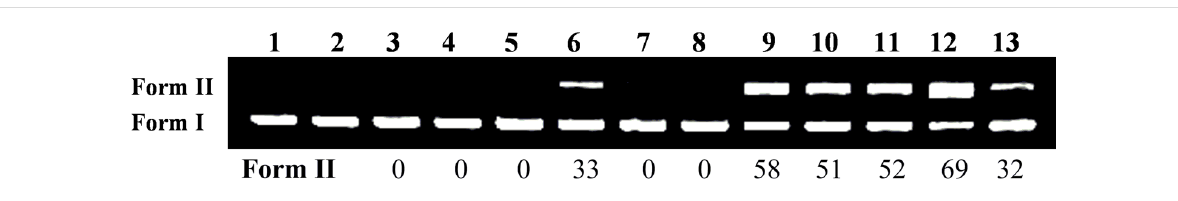
Figure 8: DNA photocleavage of compounds 8 – 10 and 12 – 13 at concentration of 500 μ M, at 365 nm, in the absence and presence of acetophenone (AP, 1 mM, absorption ≈ 0.1 at 365 nm), 2 h, 10 cm distance, aerobic conditions. wells 1 and 2 represent DNA in dark and DNA UV irradiated, respec- tively. Photo: wells 3–8: DNA + 8 , or 9 , or 10 , or 12 , or 13 + UV, respectively; well 8: DNA + AP + UV; wells 9–13: DNA + 8 , or 9 , or 10 , or 12 , or 13 + AP + UV,